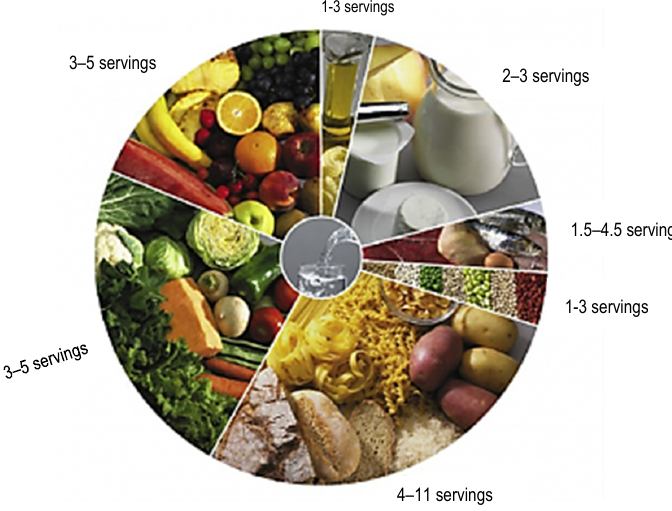
Figure 12. The Portuguese food wheel guide.